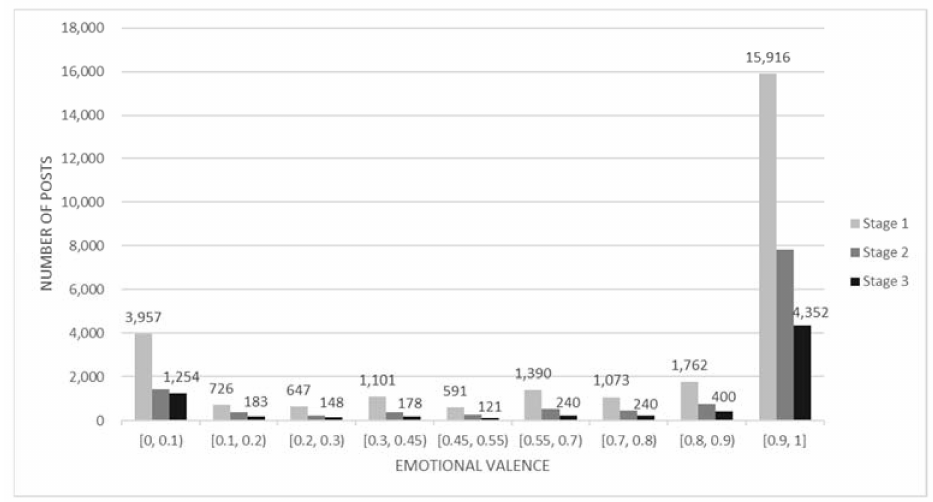
Figure 1. Segmented statistical graph of the emotional valence index of diary posts.